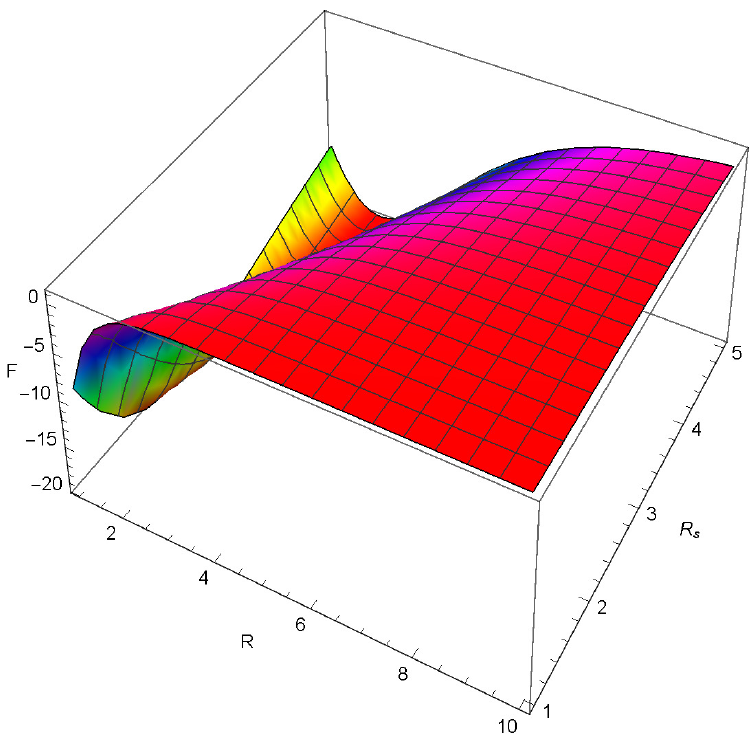
Figure 26. Solution of F ( R ( r )) for n = 2. The evolution of partial derivative of f ( R ) is obtained using Equations (33) and